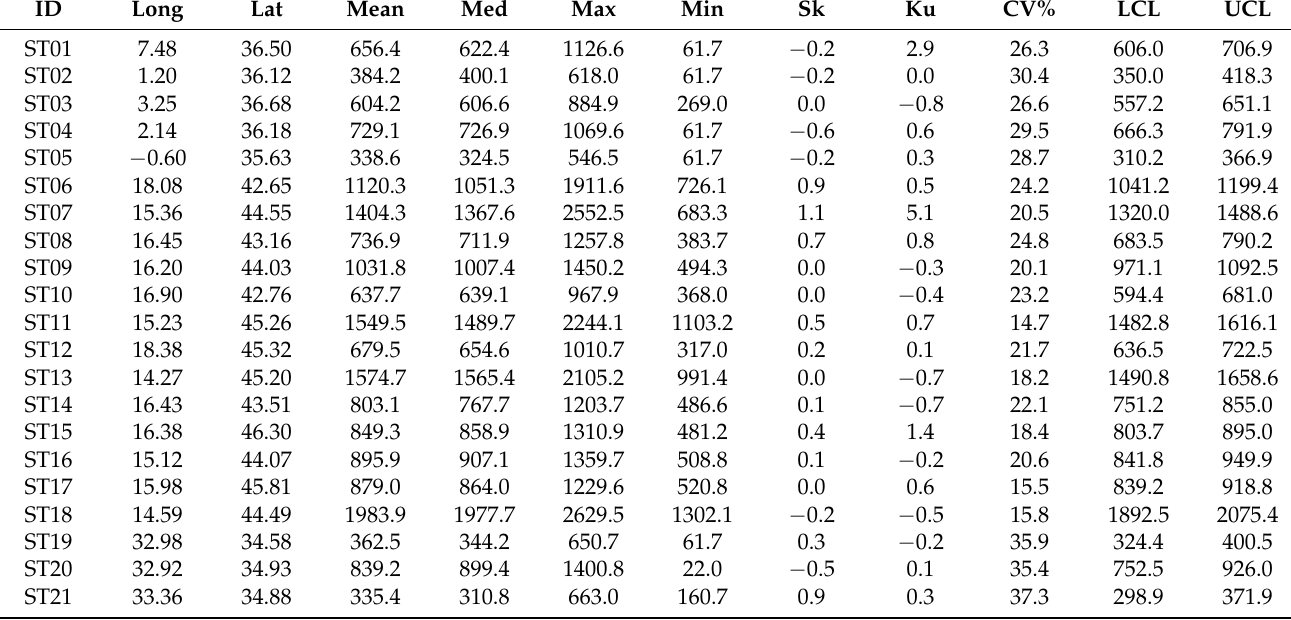
Table A1. Main statistical characteristics of total annual precipitation over the MED during